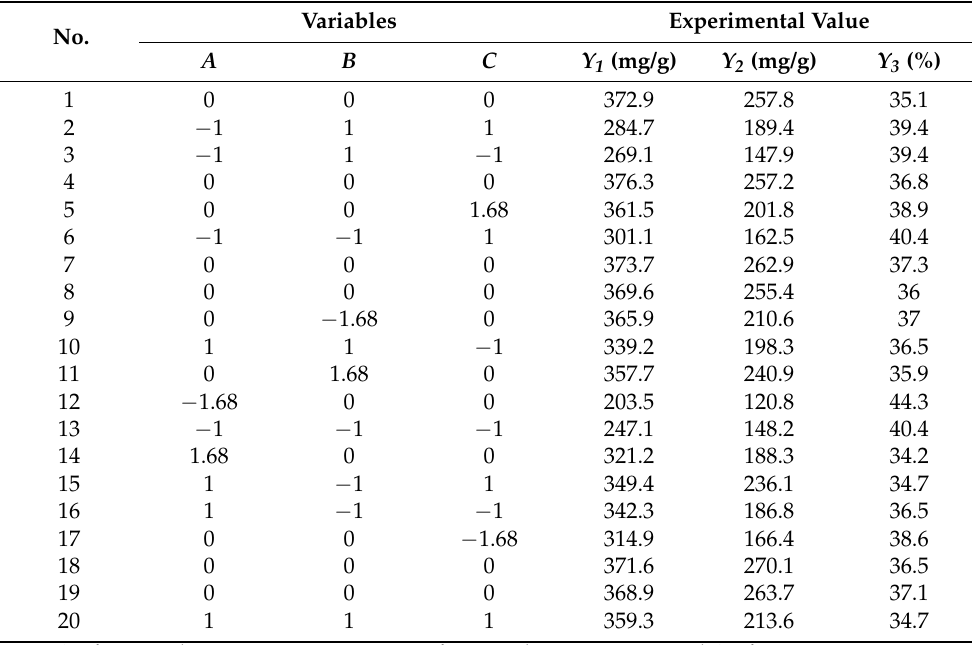
Table 2. Design of variables and experiment data of RSM. No.